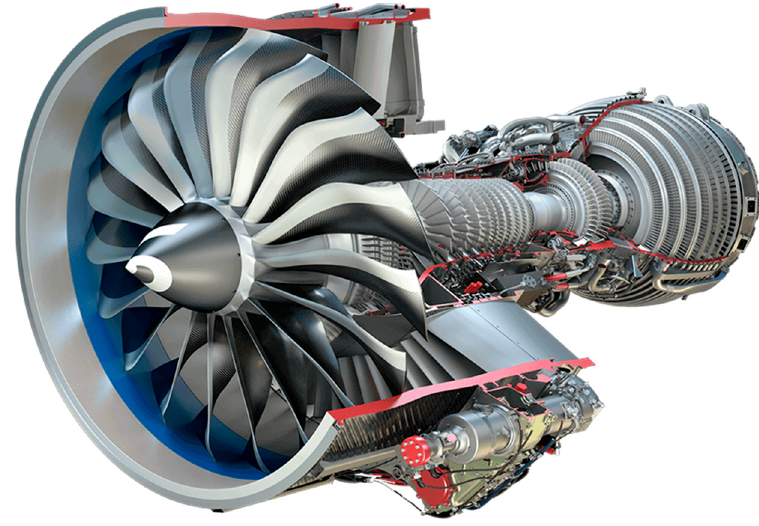
Figure 1. The cross ‐ section of an aero ‐ engine. Figure 1. The cross-section of an